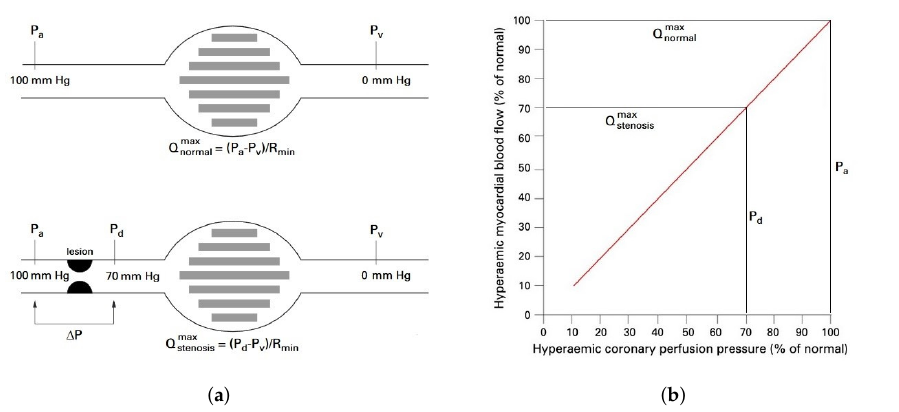
Figure 4. Graphical representation of Fractional Flow Reserve (FFR). ( a ) FFR represented graphically in the vessels; ( b ) FFR as the ratio between maximum blood flow distal to a stenotic lesion to normal maximum flow in the same